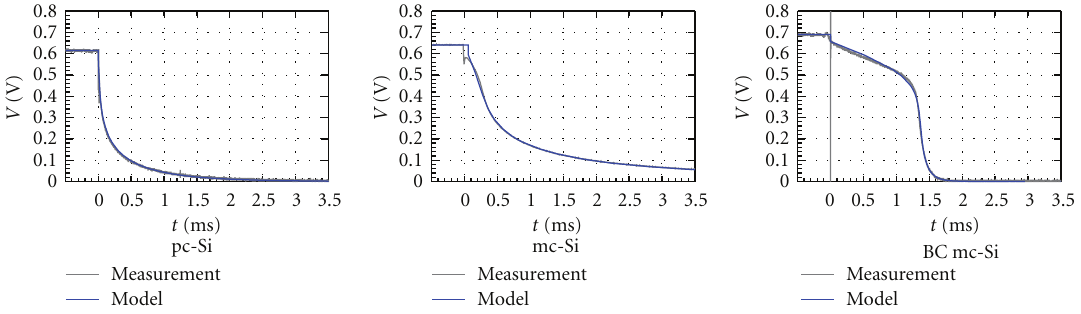
Figure 5: Alignment between modelled and measured OCVD signals of selected solar cells.